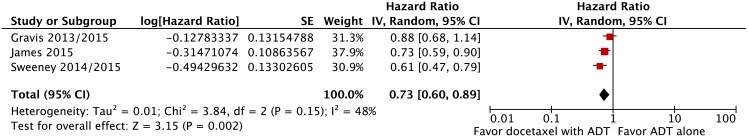
Comparative effect in overall survival of ADT with docetaxel versus ADT alone (random-effects model analysis).Abbreviations: ADT, androgen-deprivation therapy; CI, confidence interval.